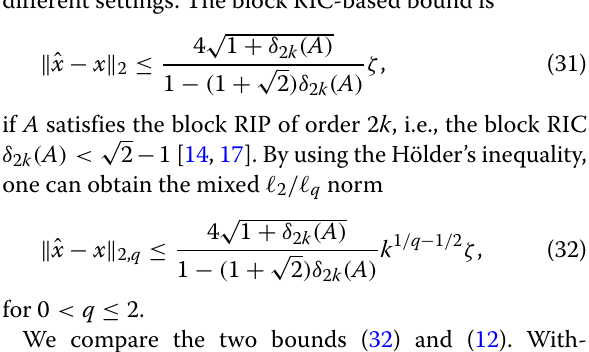
ˆ β q , s , becomes convergent, so in the following experiments, we repeat the algorithm 40 times and choose the smallest ˆ β value q , s as the “global” minima. We test indeed to vary m , s , n , respectively, all indicate 40 is a reasonable number to be chosen (not